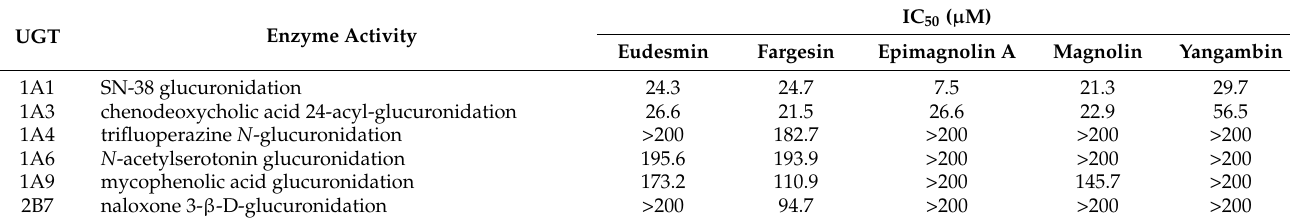
Table 1. Inhibitory potentials of eudesmin, fargesin, epimagnolin A, magnolin, and yangambin on six major UGT enzyme activities in ultrapooled human liver microsomes.